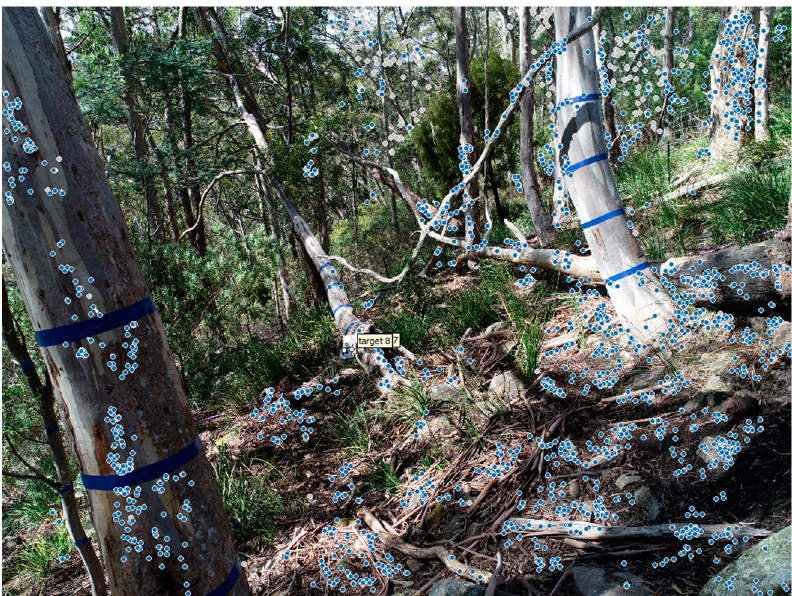
Figure A3. Tie points were visualized in Agisoft Metashape to show that while the blue tape did contribute to some tie points, most tie points came from natural features in the environment.